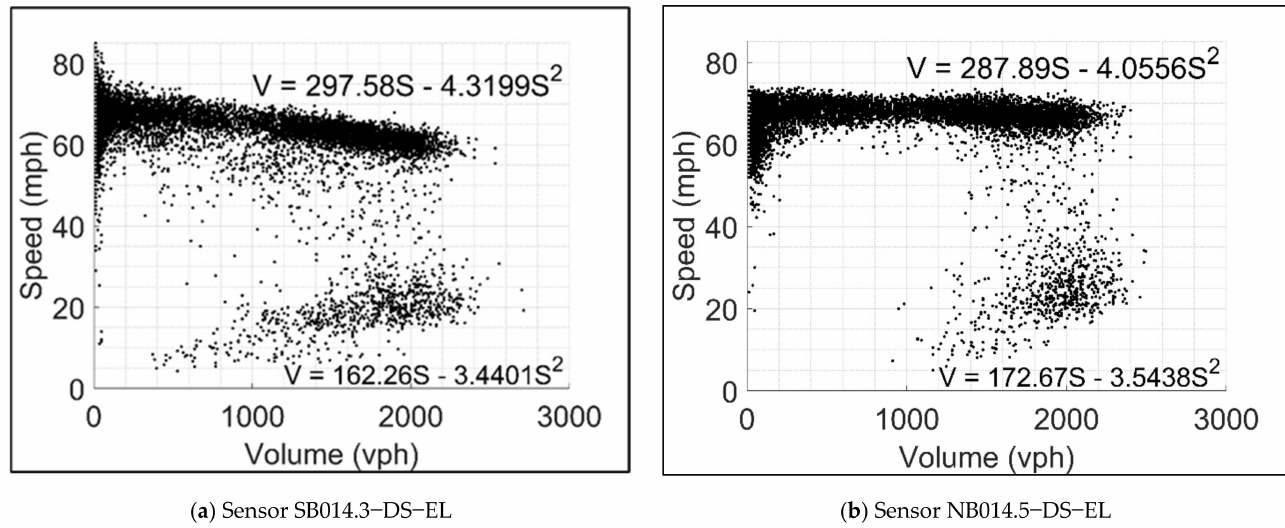
Figure 5. Speed-volume relationships from representative Northbound and Southbound